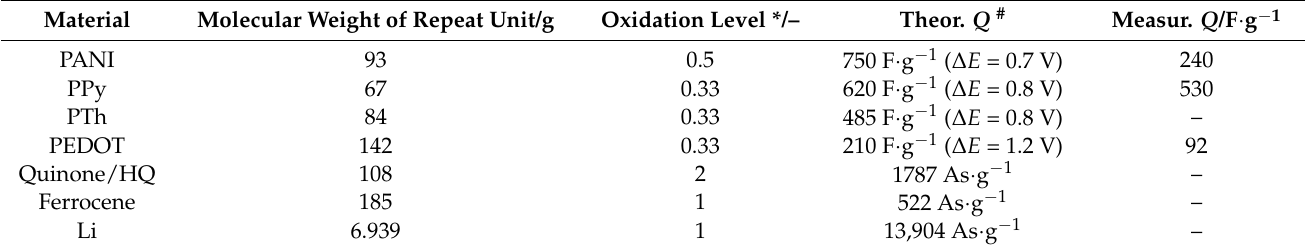
Table 1. Some electrochemical data of the selected electrode materials 1